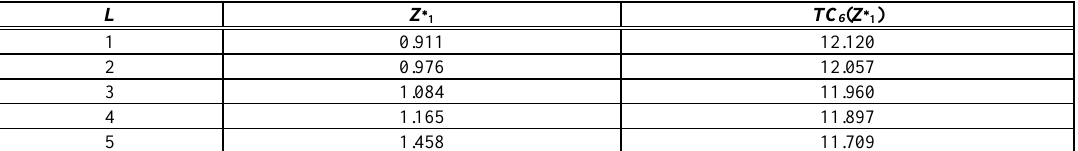
Table 7. Optimal Z ∗ 1 and TC 6 ( Z ∗ 1 ) of Model 6 for L =1, 2, 3, 4, 5 when T = 1, K =5, 𝜇 = 1 , λ = 0.1 . L Z ∗